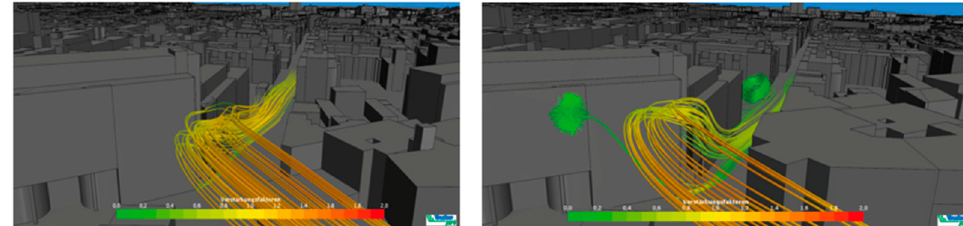
Figure 15. Changes in redirecting wind flow reducing wind speed for wind direction south-east for base case ( left ) and densification scenario ( right ).